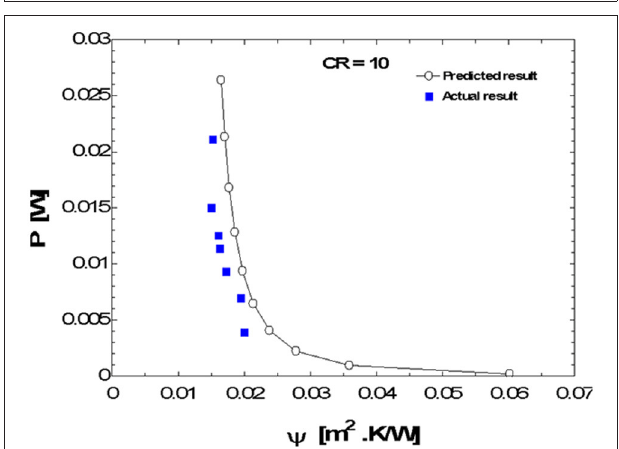
FIGURE 7 | Conversion efficiency Φ , overall efficiency η vs. system parameter ψ at CR = 10.